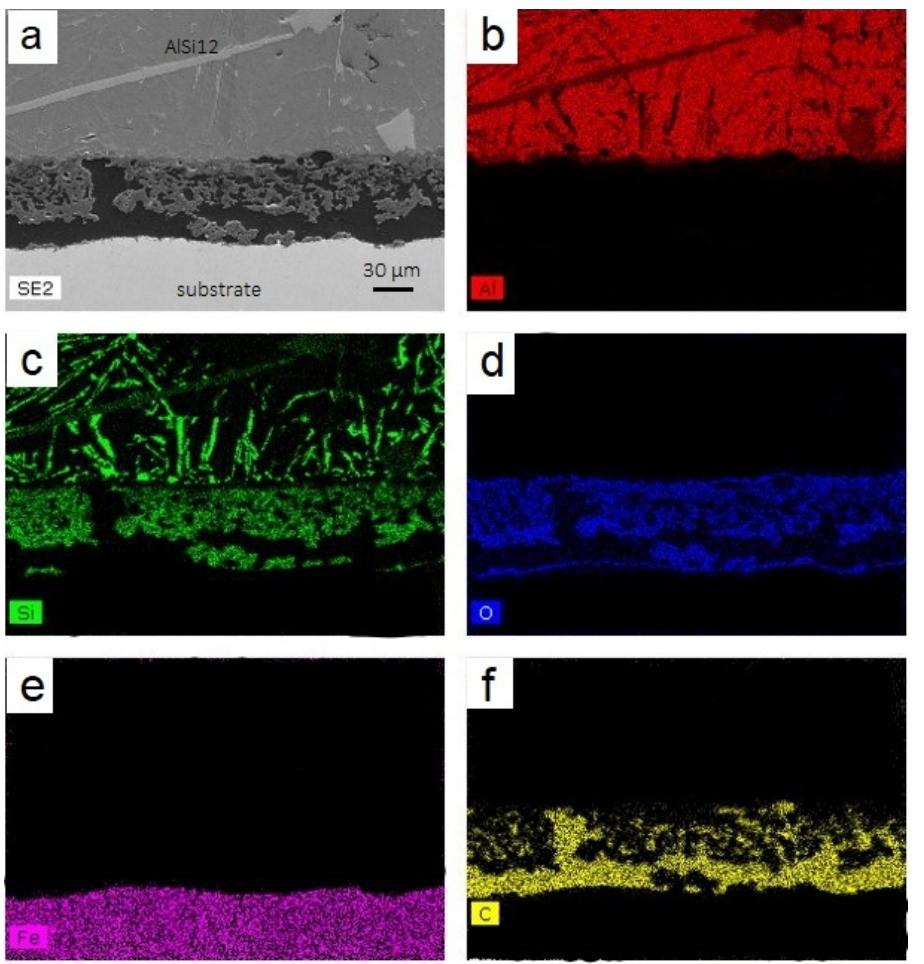
Figure 7. ( a ) Cross-sectional SEM observation of the protective layer coated on the 304L substrate after 600 h at 700 °C in AlSi 12 (300 X magnification) and EDS analysis of Al ( b ), Si ( c ), O ( d ), Fe ( e ), and C ( f ).